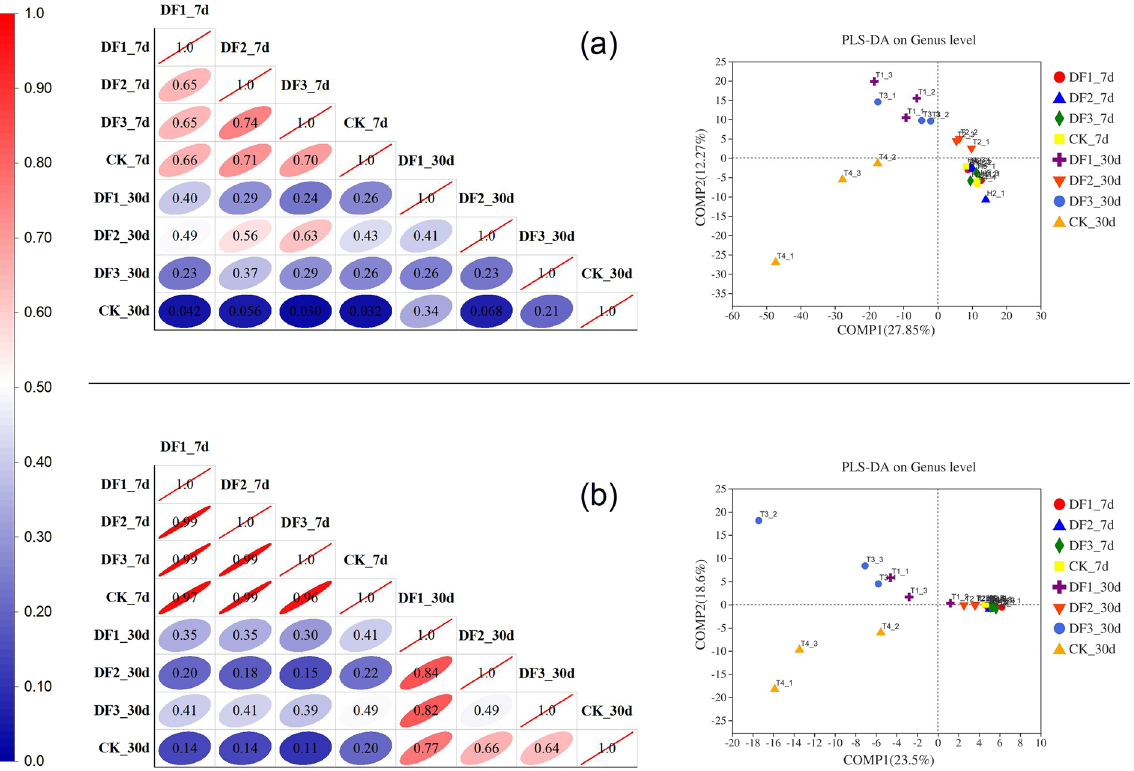
Figure 5. Pearson correlation matrix analysis (n = 978) and partial least squares discriminant analysis (PLS-DA) of compost about the bacteria ( a ) and fungus ( b ). DF1_7d, DF2_7d, DF3_7d and CK_7d represent the samples